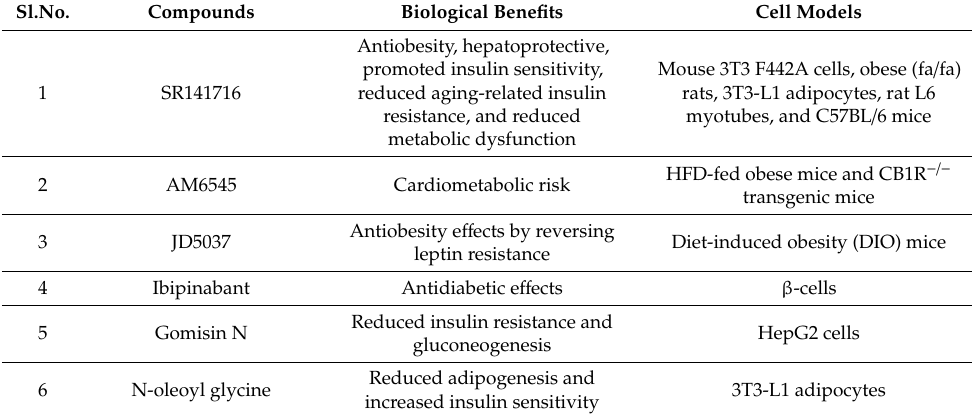
Table 2. The list of CB1R-specific antagonists, inverse agonists, and compounds that improve insulin resistance.